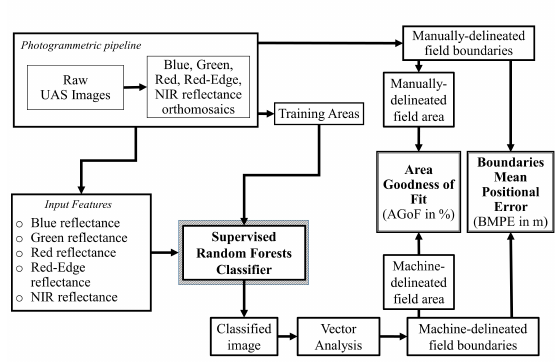
Figure 4. Flowchart of the